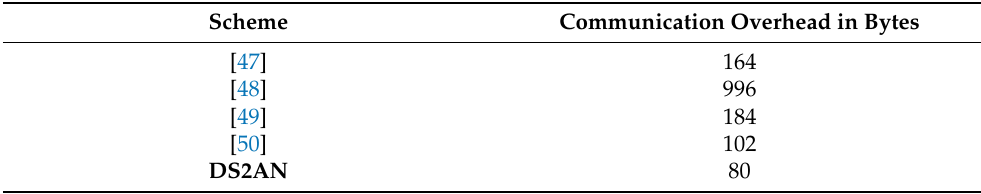
Table 7. Communication overhead